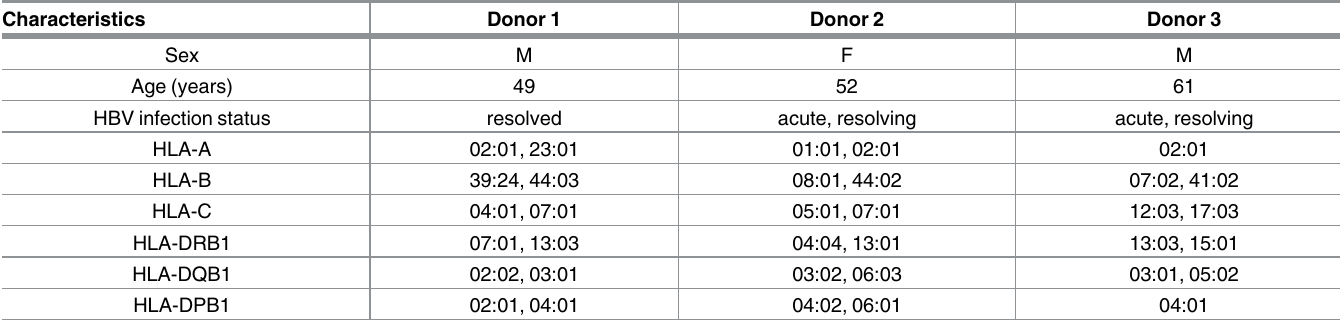
Table 1. Characteristics of donors at the time of PBMC